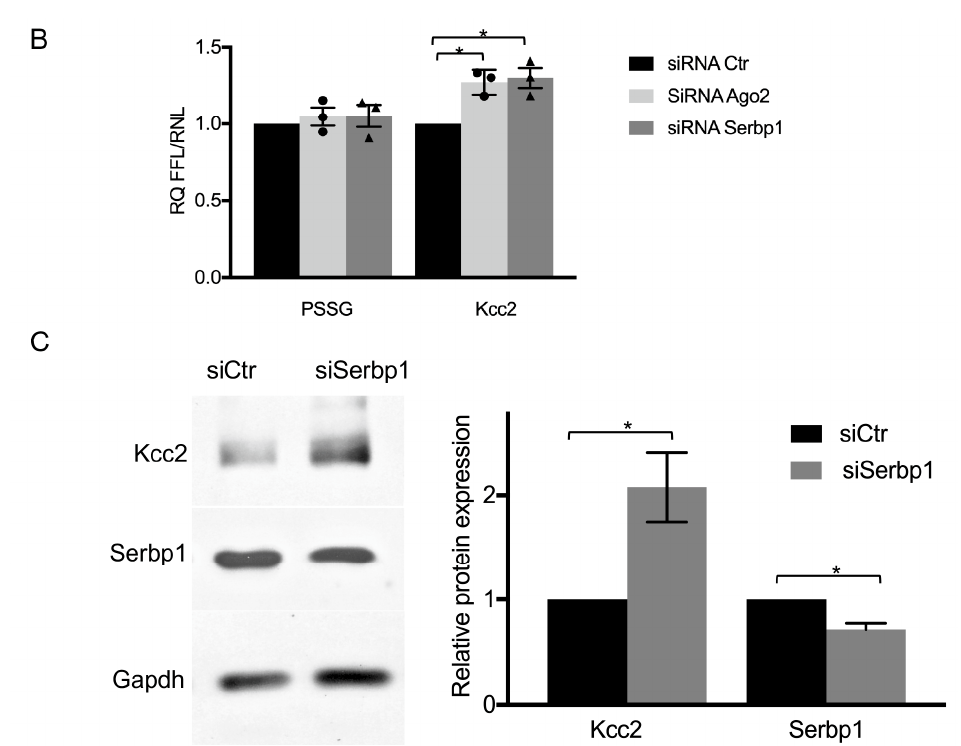
Figure 3. SERBP1 or Ago2 silencing increases KCC2 expression. ( A ) Forty-eight hours after trans- fection with either control siRNA, Ago2 siRNA or SERBP1 siRNA (20 nM), SH-SY5Y cells were transfected with PSSG control plasmid or the Serpine1, or APP or KCC2 3 (cid:48) UTR firefly reporter plasmid. Firefly/renilla luminescence ratios were determined 24 h later. The data are presented as the fold increase of normalized luminescence ratios relative to cells transfected with control siRNA. Data represent the mean of three independent experiments +/ − S.E.; * p < 0.05; ** p < 0.01. ( B ) Forty- eight hours after transfection with siAgo2 or siSERBP1 or a control siRNA (200 nM), hippocampal neurons were transfected with control plasmid or KCC2 3 (cid:48) UTR luciferase reporter. Firefly/renilla luminescence ratio was analyzed as described in ( A ). Data represent the mean of three independent experiments ± S.E. * p < 0.05. Individual data points for Ago2 (circles) and Serbp1 (triangles) siRNA transfected cells are indicated in ( A ) and ( B ) panels. ( C ) Representative Western blotting showing KCC2 upregulation in hippocampal neurons after SERBP1 silencing. Nitrocellulose membranes were hybridized with KCC2 or SERBP1 antibodies, as indicated. The GAPDH signal was used to normalize different samples. Means +/ − S.E. of KCC2 and SERBP1 protein levels obtained from three independent experiments are presented relative to control cells. * p < 0.05; ** p < 0.01 ( t